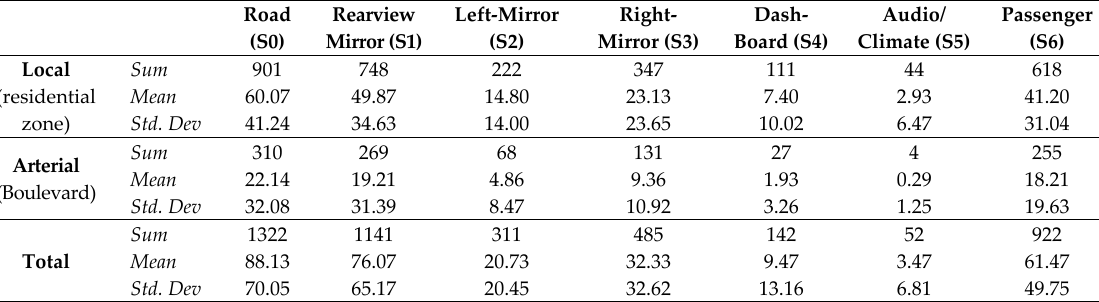
Table 2. Frequency of glances to each cockpit’s